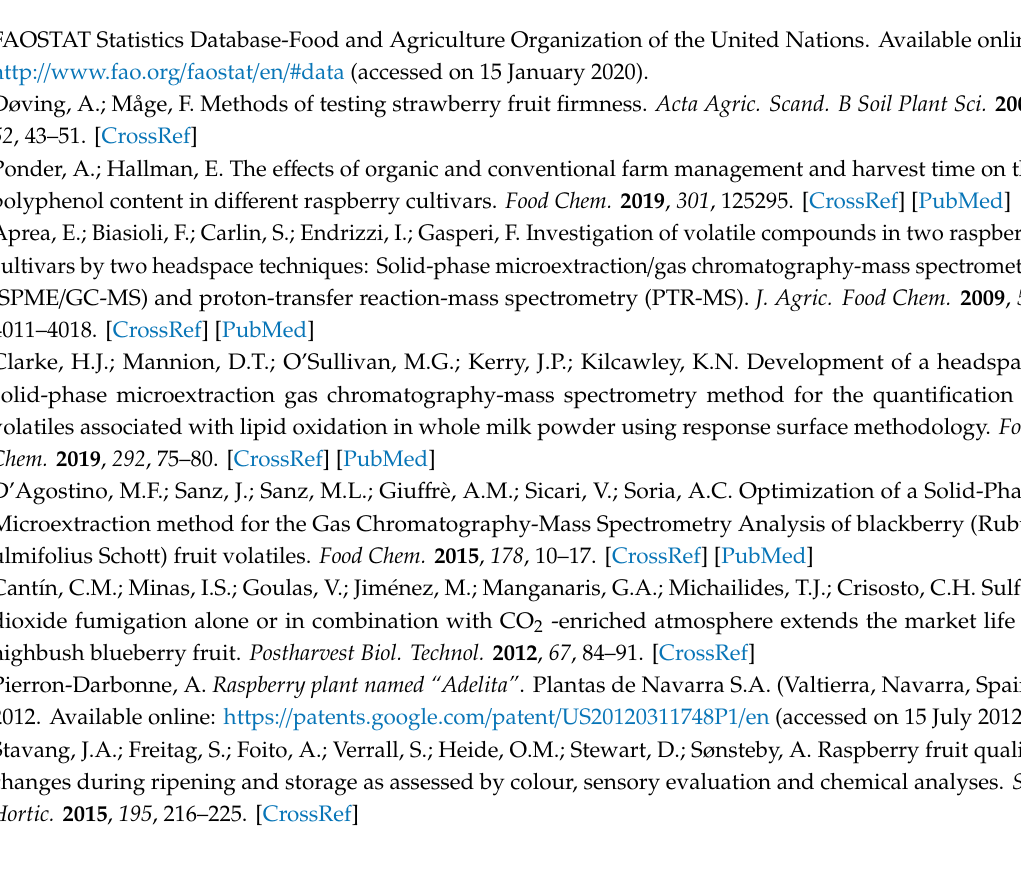
Figure S1: Raspberry cultivars used in this study. Table S1: Validation parameters for the HS-SPME / GM-MS optimised method: Linear range (mg Kg − 1 ), R 2 value, LOD ( µ g Kg − 1 ), LOQ ( µ g Kg − 1 ), intra-day and inter-day repeatability (peak area RSD